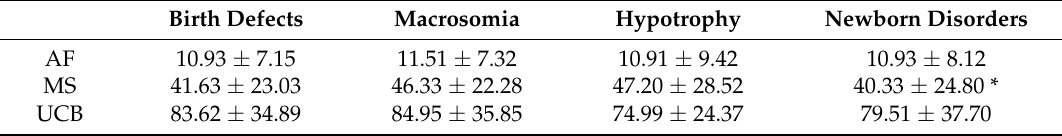
Table 4. Folate concentration; mean ± SD/median/min − max (nmol).